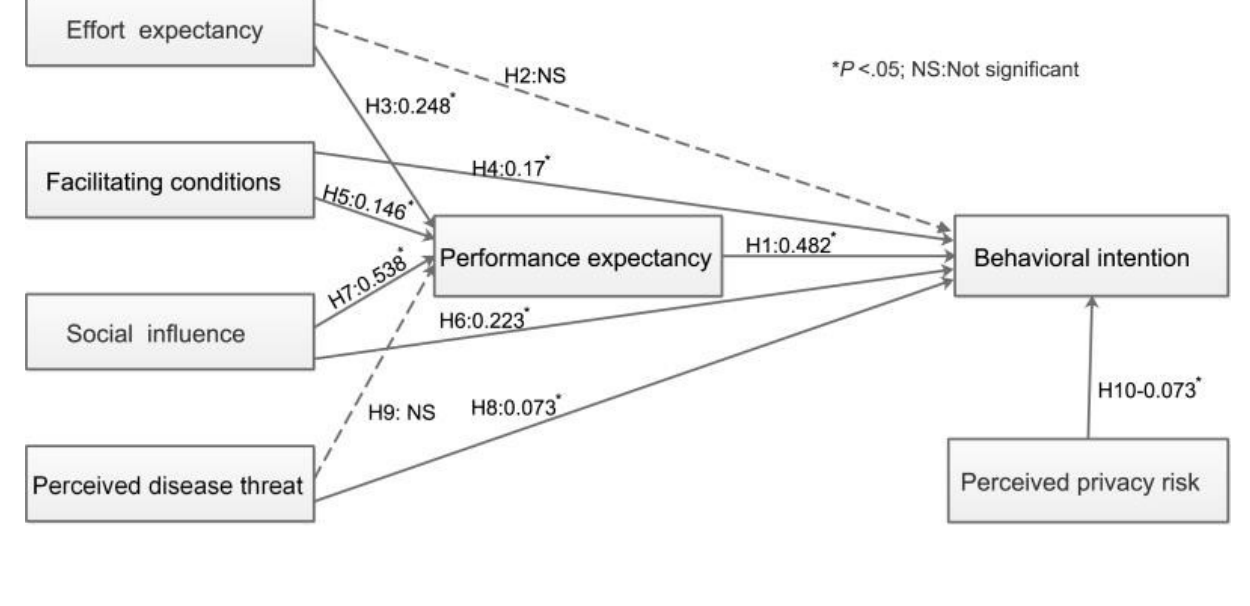
Figure 3. Research model explaining performance expectancy and behavioral intention (direct effects). H1: Performance expectancy positively influences the behavioral intention of patients to use diabetes management apps, H2: Effort expectancy positively influences the behavioral intention of patients to use diabetes management apps, H3: Effort expectancy positively influences performance expectancy, H4: Facilitating conditions positively influence the behavioral intention of patients to use diabetes management apps, H5: Facilitating conditions positively influence performance expectancy, H6: Social influence positively influences the behavioral intention of patients to use diabetes management apps, H7: Social influence positively influences performance expectancy, H8: Perceived disease threat positively influences the behavioral intention of patients to use diabetes management apps, H9: Perceived disease threat positively influences performance